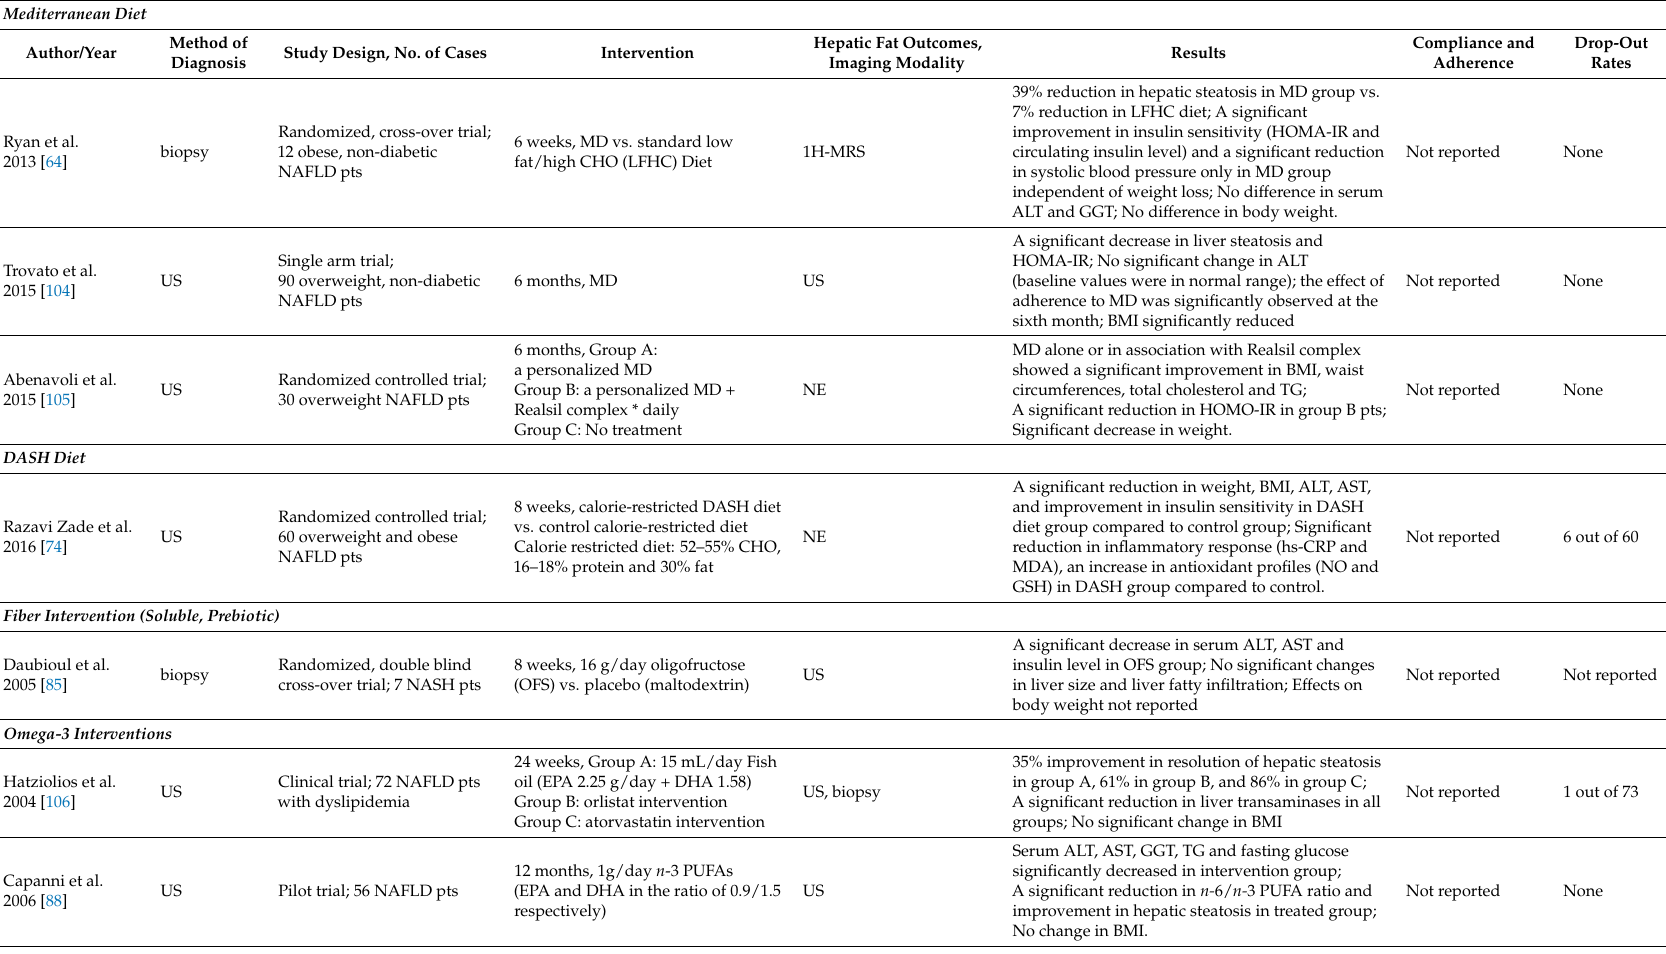
Table A1. Published clinical trials on the effect of dietary compositions and patterns in adult patients with